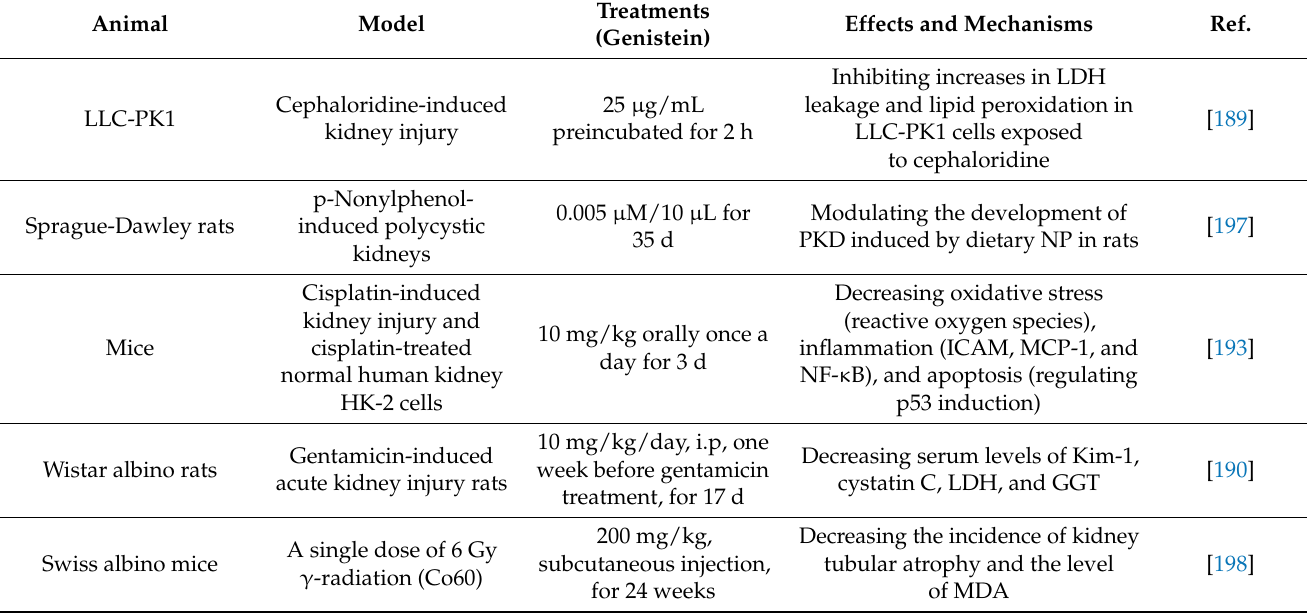
Table 6. The effects of genistein attenuating injury caused by medications and irradiation. Treatments Effects and Mechanisms Animal Model (Genistein)